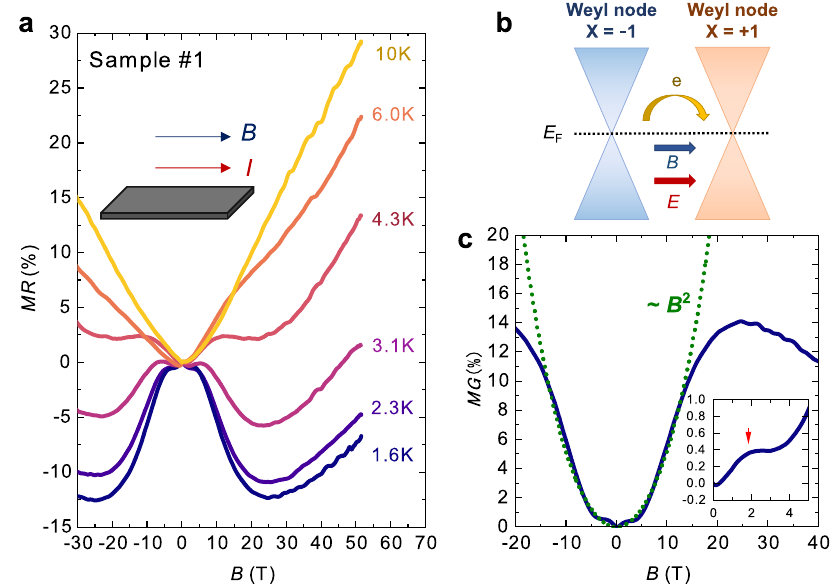
Fig. 3|Negativemagnetoresistance(MR)in α -(BETS) 2 I 3 .a LongitudinalMRof α - (BETS) 2 I 3 ( I // B ). The magnetic- fi eld dependence of MR was measured at several temperatures. The quadratic negative magnetoresistance can be observed below 4K. b Schematic of the charge fl ow induced by CME. In a magnetic fi eld, the positive magnetoconductance (MG) due to the chiral anomaly fl ows between two